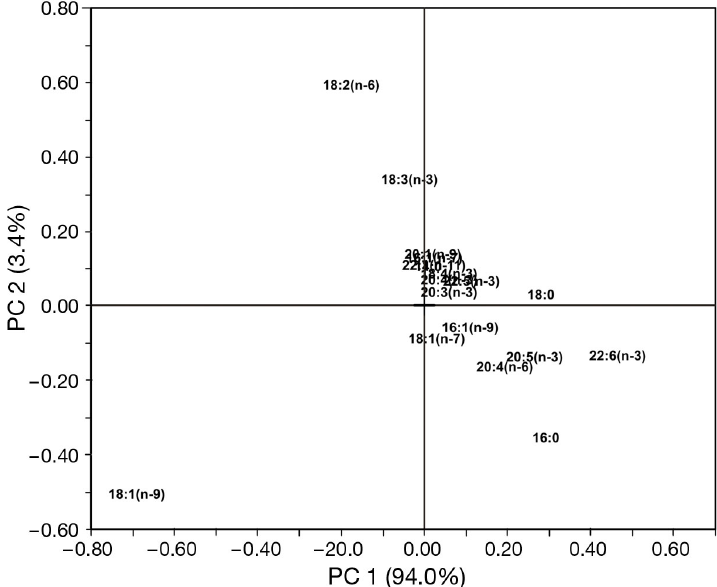
Fig. 2. Salmo salar . Loading plot of principal component (PC) analysis built on fatty acids in total lipids and triacylglycerols in the adipose fin and mus- cle of farmed salmon (see score plot in Fig. 1). Fatty acids closer to the origin are not